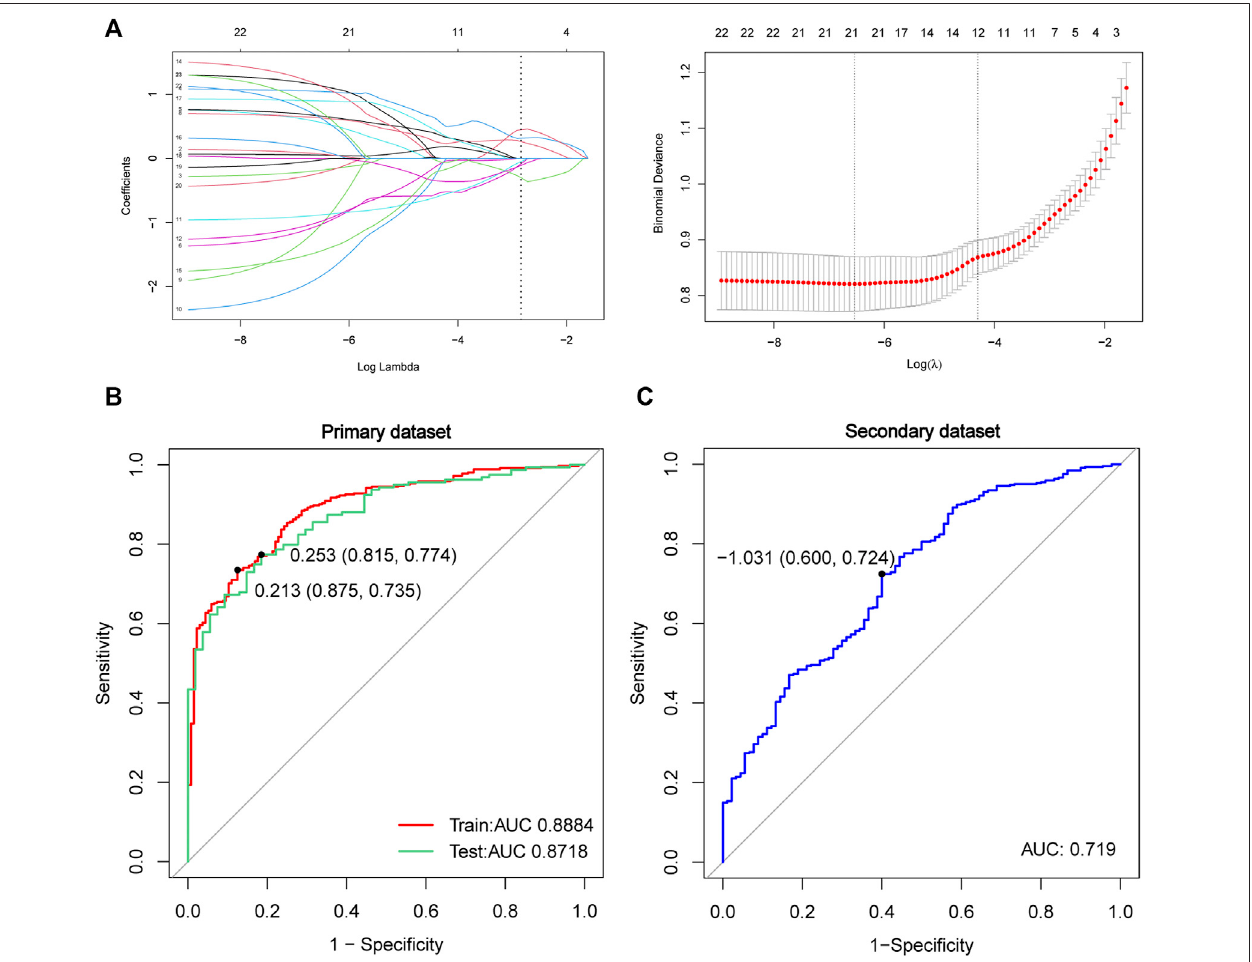
FIGURE 6 | Construction and validation of the LASSO model in the primary data. (A) Construction of the LASSO model by the overlapped 22 genes. The ROC curveintheprimarydatasetoftraining data(redlines,N=498,AUC=0.8884), testingdata(green lines,N=213,AUC=0.8718) (B) ,and inthesecondary dataset(blue lines,N=532,AUC=0.719) (C) Redlinerepresentstrainingdata,thegreenlinerepresents testdata,andthebluelinerepresentsthesecondarydataset.Abbreviations: LASSO, least absolute shrinkage and selection operator; ROC, receiver of characteristic curve; AUC, area under curve.